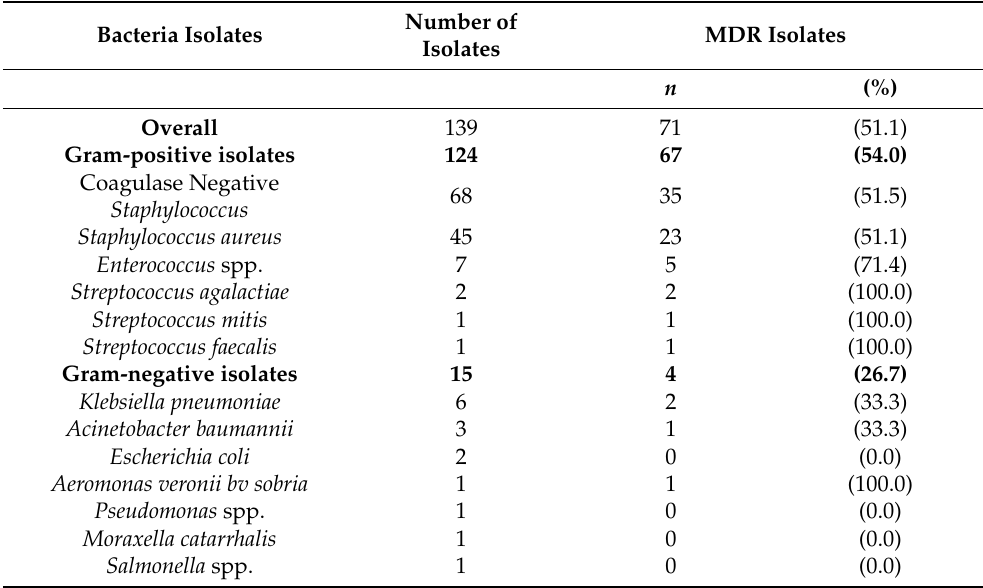
Table 5. Multidrug resistance among neonates with suspected sepsis who underwent culture and